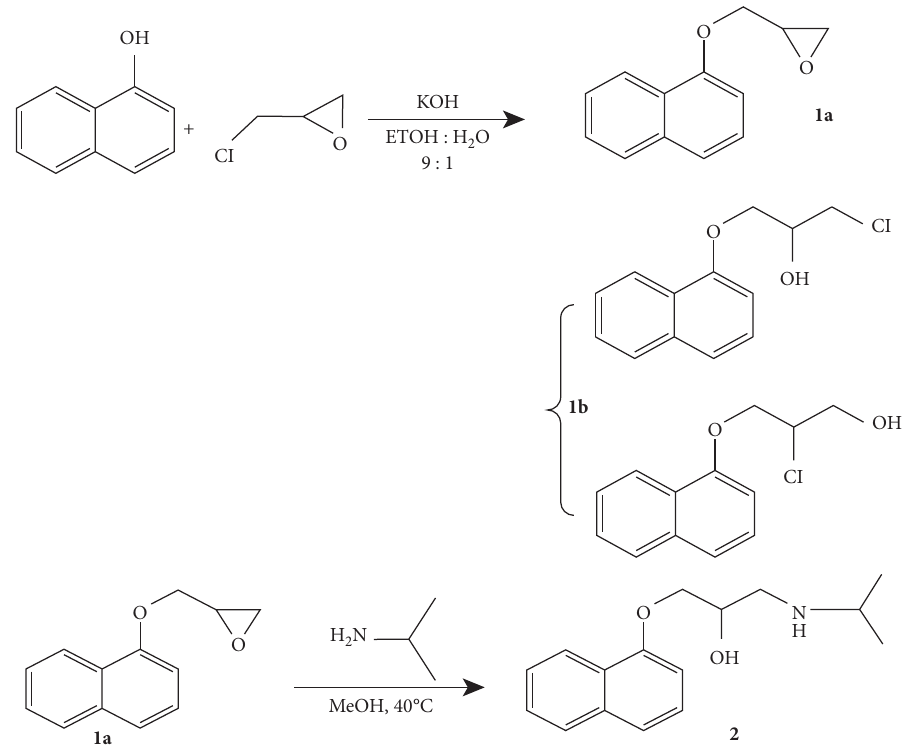
Figure 2: The scheme illustrates the synthesis reaction of propranolol from 1-naphthol and